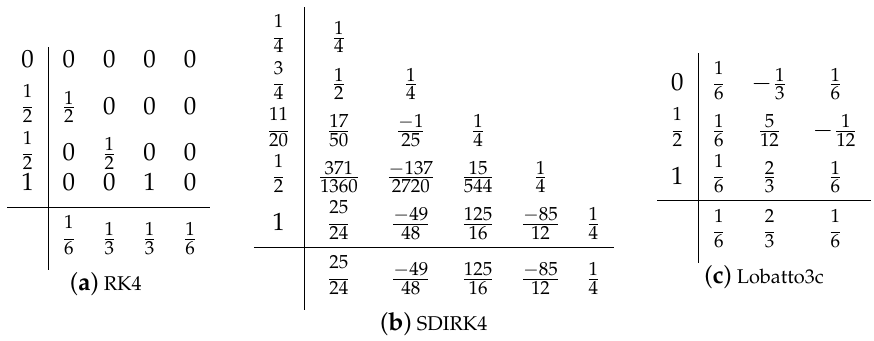
Figure 1. Different kinds of Runge–Kutta methods